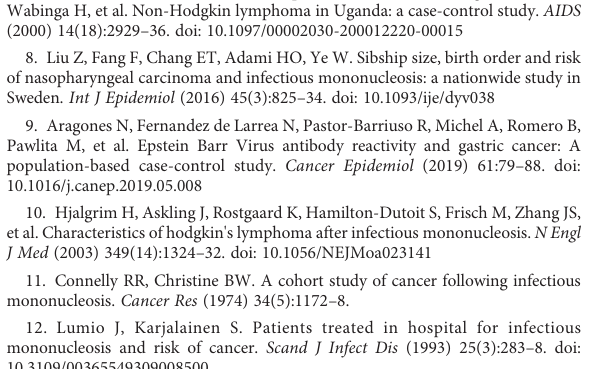
SUPPLEMENTARY TABLE 2 Risks of Subtypes of Malignancy According to Infectious Mononucleosis (IM) with or without Complication. EBV, Epstein-Barr virus. The analyses were adjusted for sex, maternal age at delivery, parity, maternal age, maternal education, maternal residence, parental malignancy history· SUPPLEMENTARY TABLE 3 Risks of Subtypes of Malignancy According to Infectious Mononucleosis (IM) with Different Duration of IM. EBV, Epstein-Barr virus. The analyses wereadjustedforsex,maternalageatdelivery,parity,maternaleducation, maternal residence, parental malignancy history. SUPPLEMENTARY TABLE 4 Risks of Subtypes of Malignancy According to Infectious Mononucleosis (IM) with Different Follow-up Periods. EBV, Epstein-Barr virus. SUPPLEMENTARY TABLE 5 Risk of Subtypes of Malignancy According to Onset Age of Infectious Mononucleosis (IM). IM, Infectious Mononucleosis. The analyses were adjusted for sex, maternal age at delivery, parity, maternal education, maternal residence, parental malignancy history. SUPPLEMENTARY FIGURE 1 Flowchart of the Study Population. IM, infectious mononucleosis; EBV, Epstein-Barr virus. 2,754,410 singletons born in Denmark during 1973-2016 were included in the study by excluding 14,622 persons due to stillbirth or information missing. Within the total cohort of 1,419,407 after matching by gender and birth year, 5,394 were exposed to EBV-IM and of these 49 developed total malignancies, 16 developed hematopoietic malignancy and 31 developed other malignancy excluding hematologic